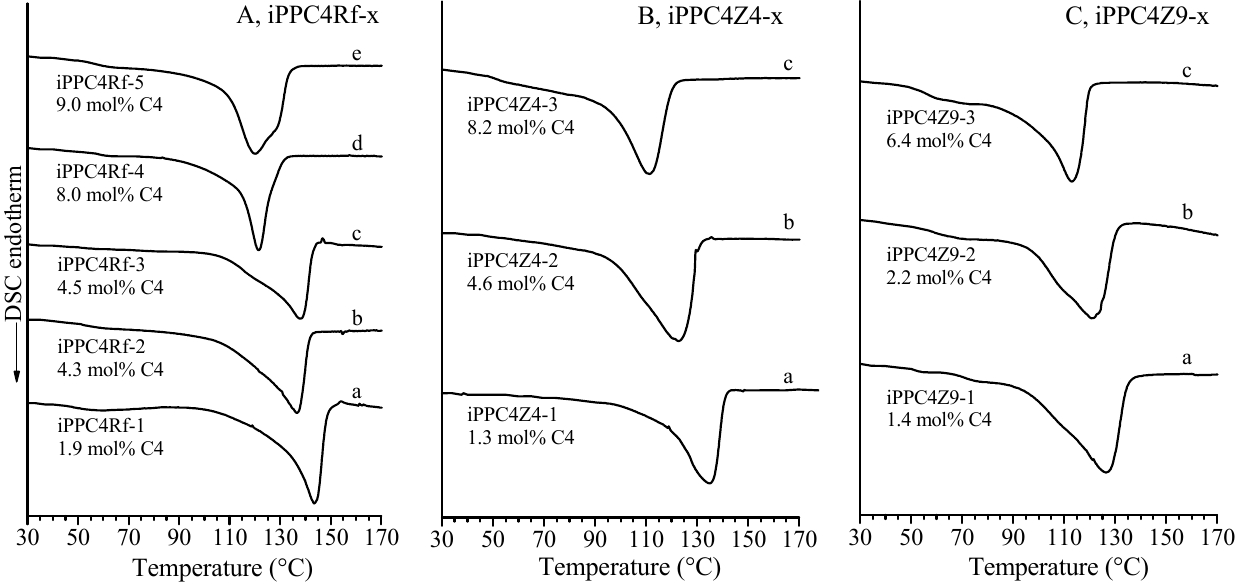
Figure 3. DSC heating curves recorded at 10 °C/min of as-prepared samples of iPPC4 copolymers of the indicated butene concentration. Isotactic samples iPPC4Rf-x with [ rr ] < 0.1 mol% ( A ) and less isotactic samples iPPC4Z4-x with [ rr ] = 2.0–2.4 mol% ( B ) and iPPC4Z9-x with [ rr ] = 2.5–3.4 mol% ( C ).